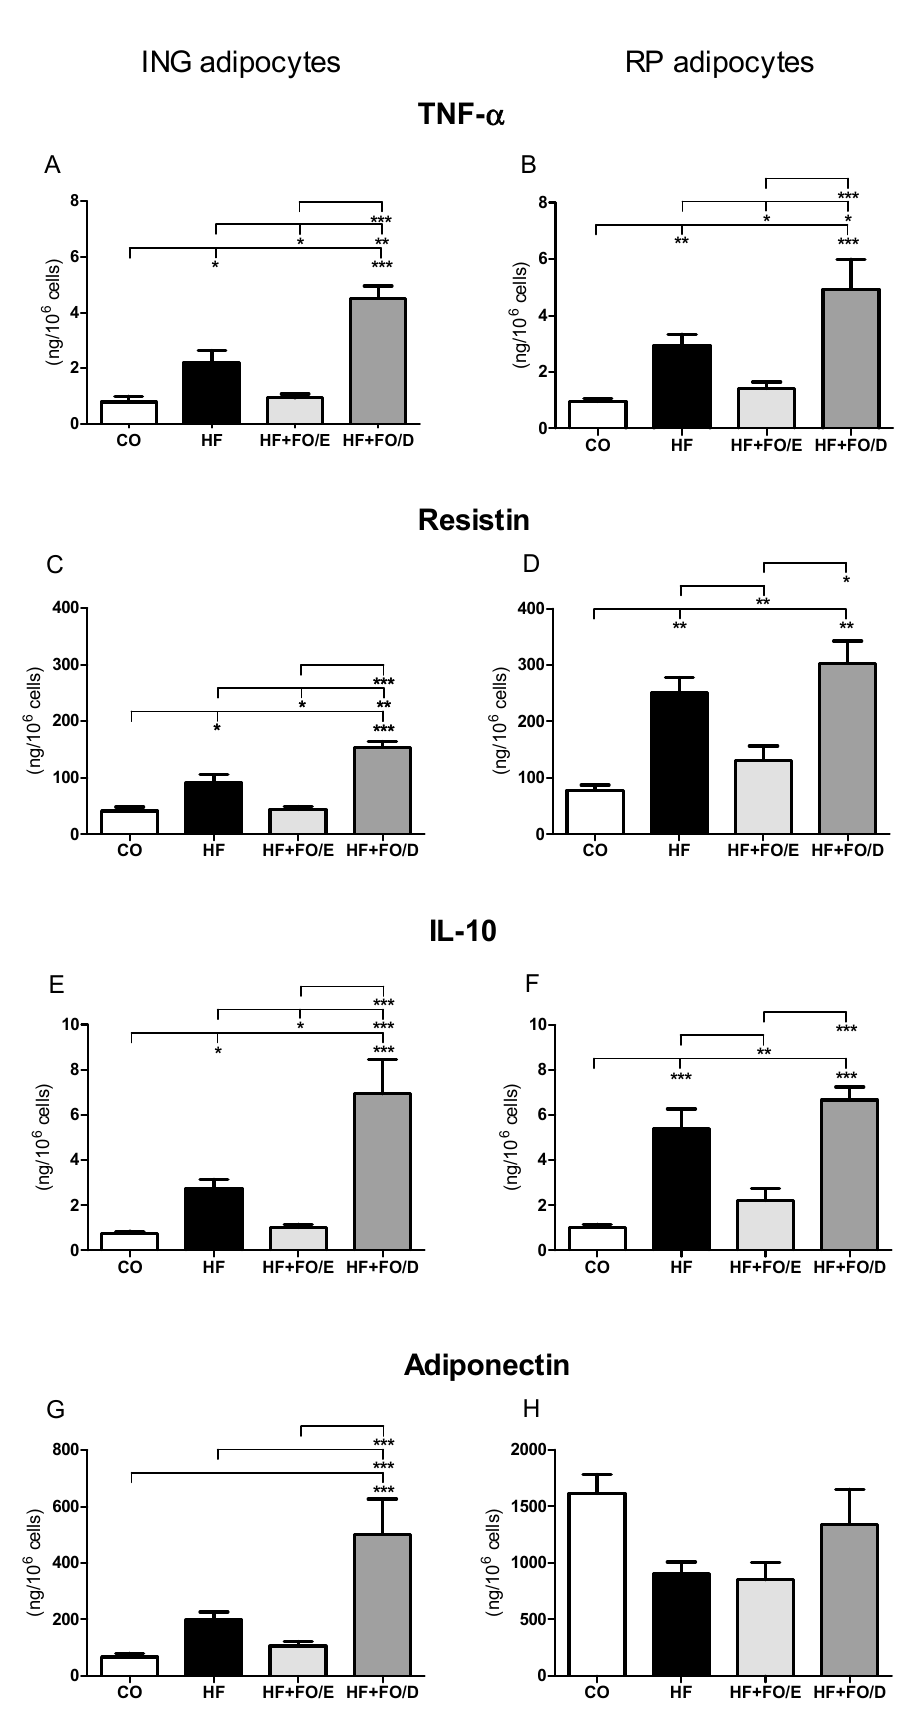
Figure 6. Secretion of cytokines by isolated adipocytes from ING and RP fat depots. ( A ) TNF-